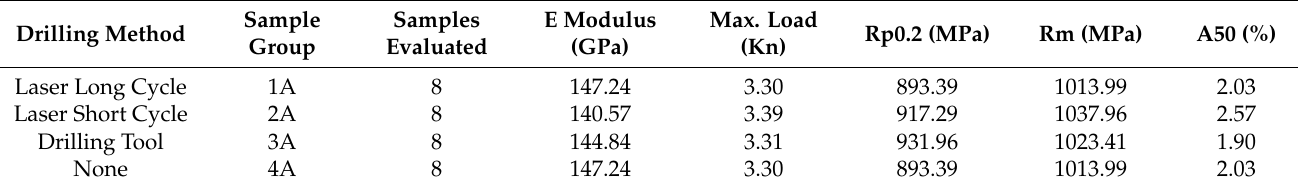
Table 9. Average values of mechanical properties—Inconel 718; material thickness 0.5 mm; tests at elevated temperature. Drilling Method